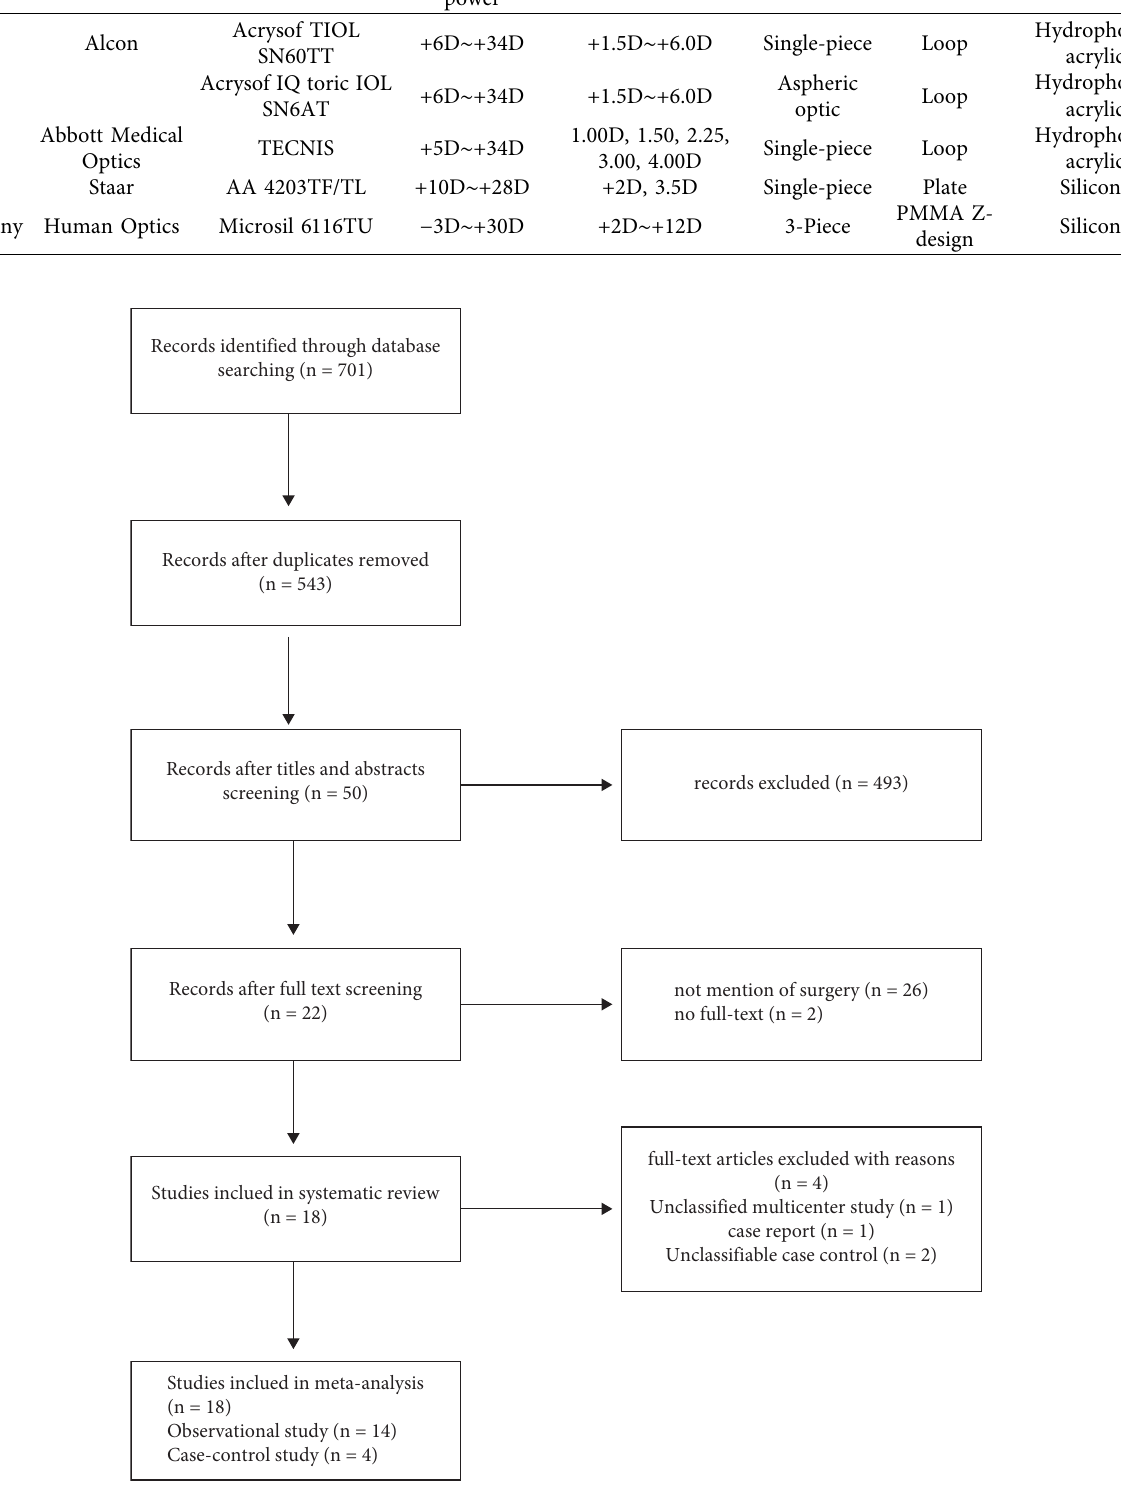
Figure 1: Flowchart demonstrating how the identified published studies were included in the